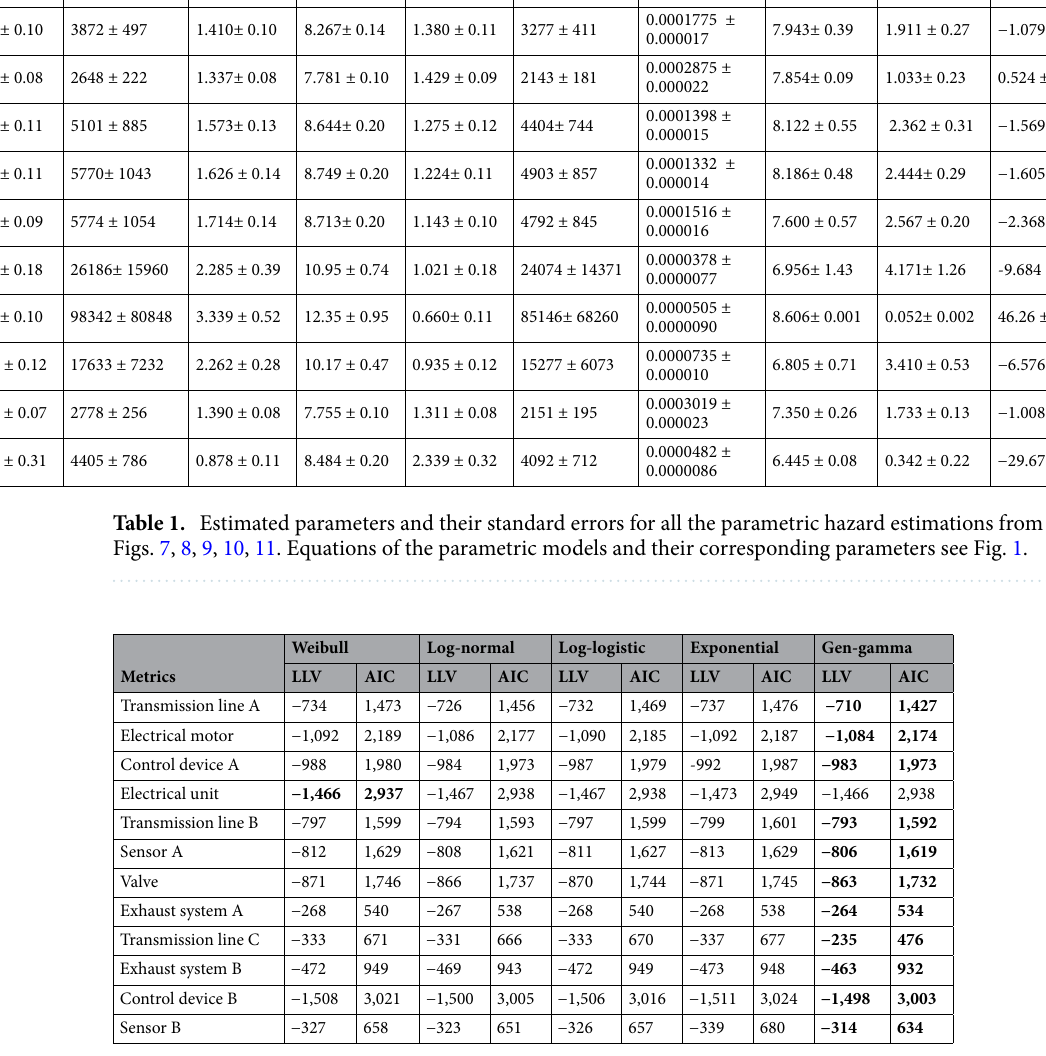
Table 2. Goodness-of-fit scores to evaluate the fit of parametric models. The studied scores are LLV (log likelihood value) and AIC (Akaike information criterion). Significance values are in